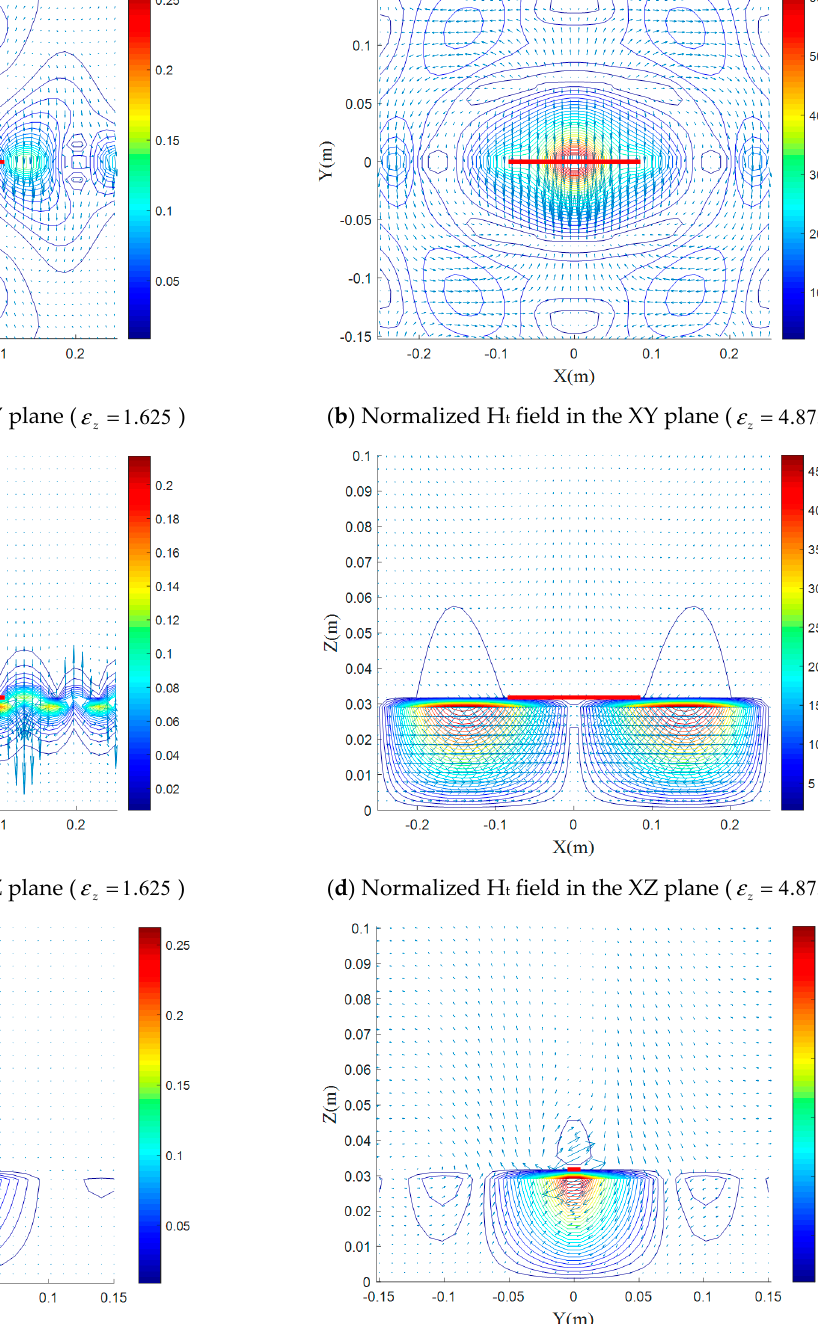
Figure 6. ( a – f ) Normalized magnetic field distributions for various values of ε z with ε t = 3.25, µ z = 1 and µ t = 1 in the XY, XZ and YZ planes.